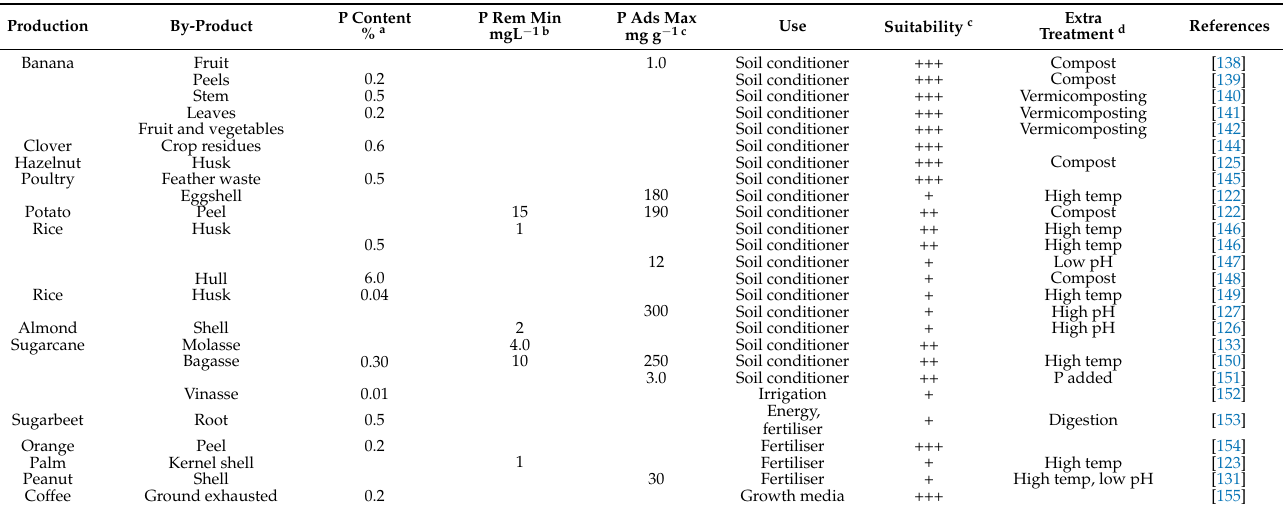
Table 6. Alternative, environmentally friendly, economic strategies for nutrient recovery of resource- rich crop